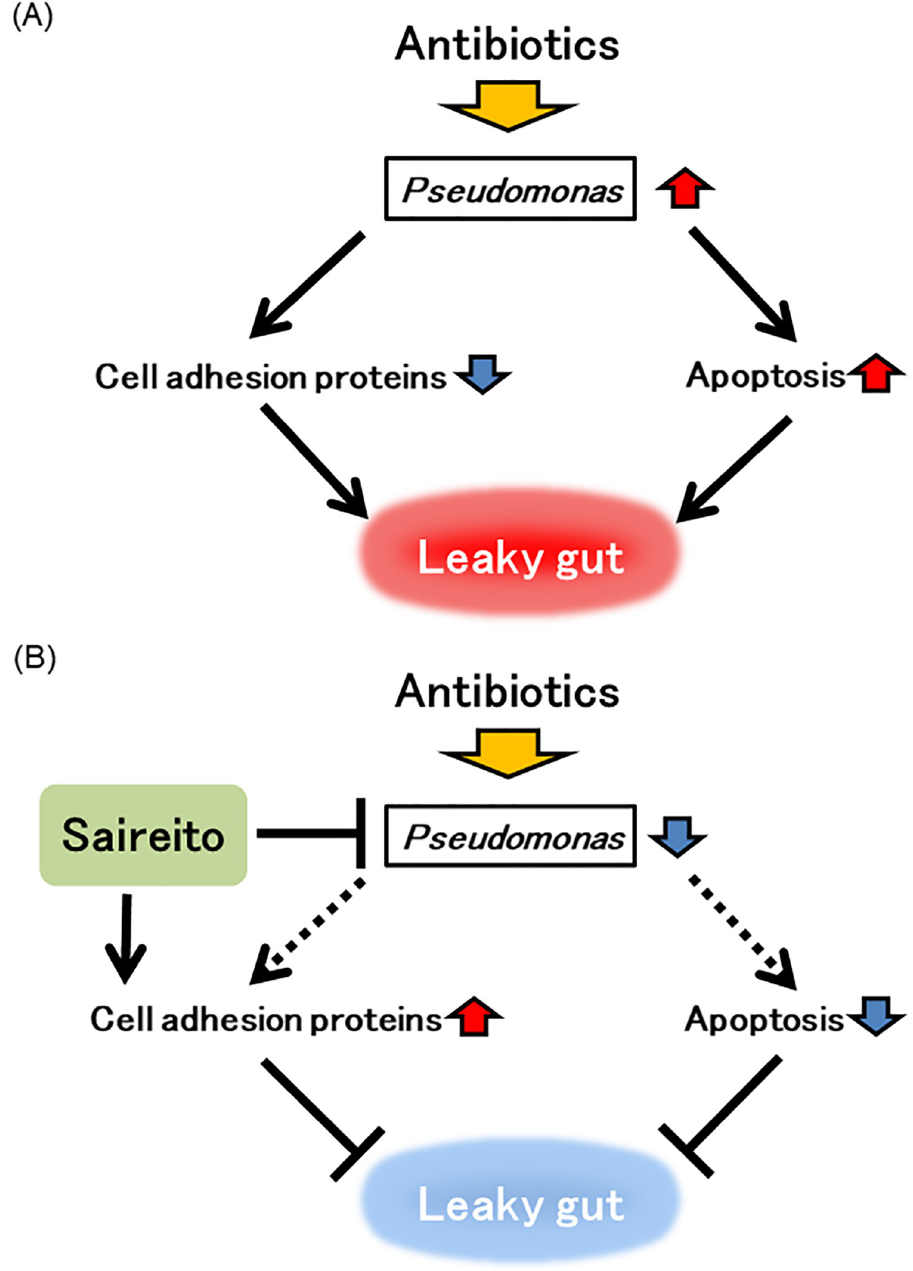
Fig 7. A model for the effect of Saireito on leaky gut associated with antibiotic-induced dysbiosis. The figure summarizes the results of this study. (A) Antibiotic therapy disturbs the normal gut microbiota. Pseudomonas spp ., which is mostly occupied in the colon of mice treated with antibiotic, disrupts the intestinal epithelial barrier by decreasing the expression of TJPs and increasing epithelial cell apoptosis. (B) Saireito may suppress the growth of Pseudomonas spp ., enhance the expression of TJPs and inhibit intestinal epithelial apoptosis, which contributes to alleviates leaky gut in antibiotic-treated mice.